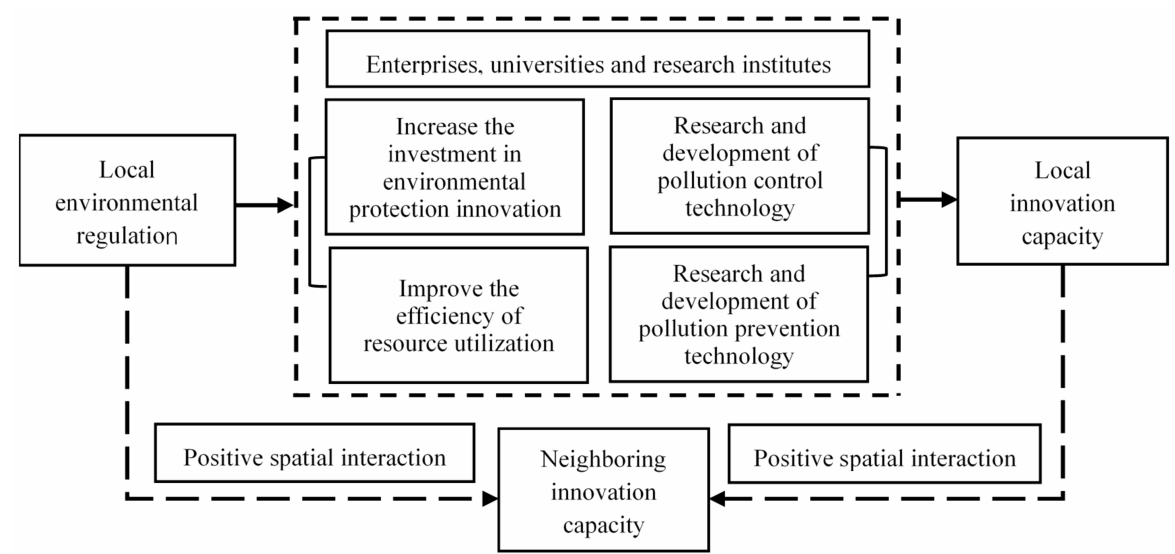
Figure 1. Mechanism of the impact of environmental regulation on urban innovation